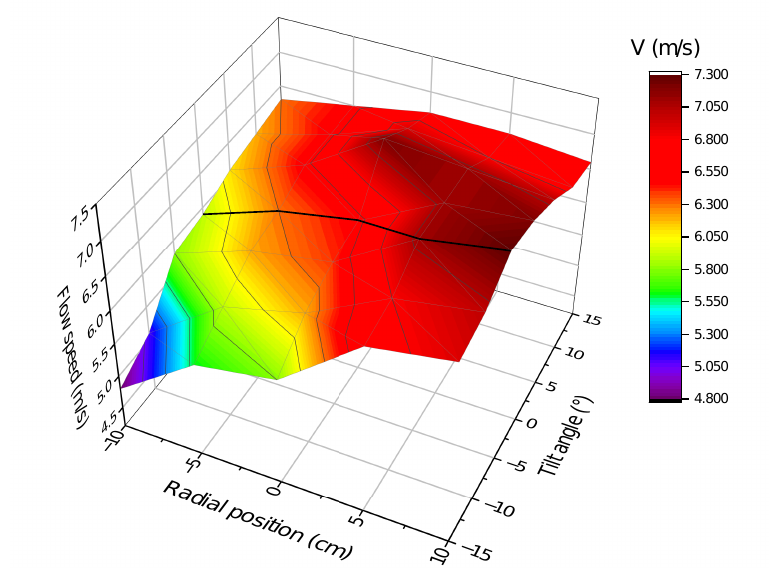
Figure 15. Plot of the flow field, along a diameter of the stack, with different Pitot angles with respect to the duct axis. Units are